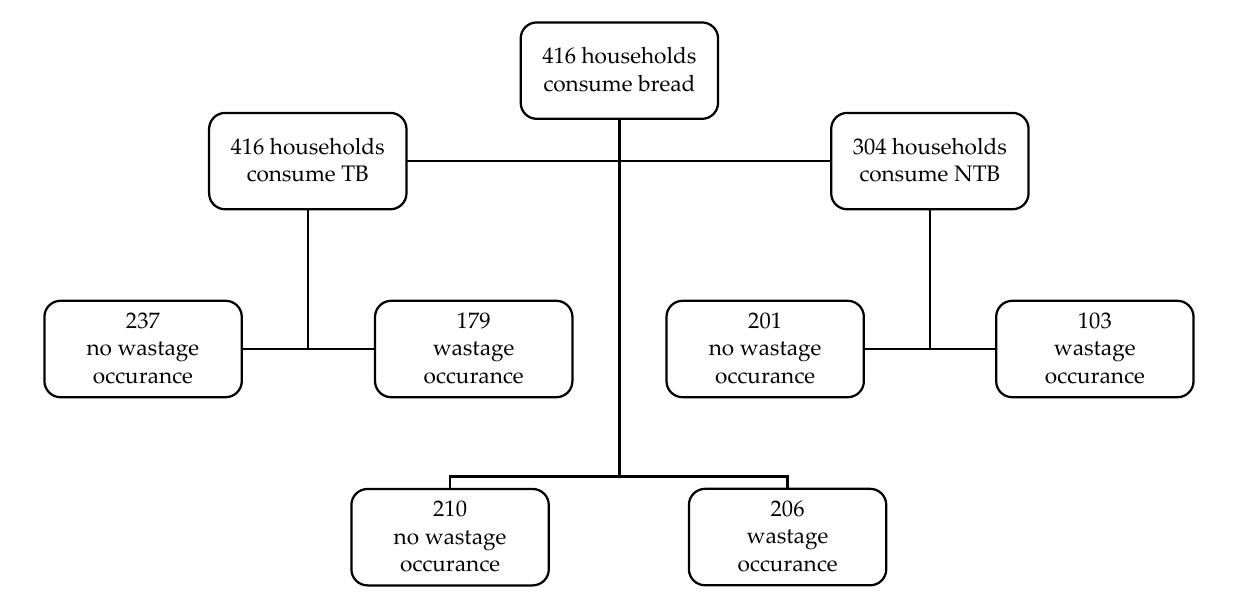
Figure 1. Schematic presentation of the number of households that consume bread and the number of households where bread wastage occurs, grouped based on bread categories; TB = traditional bread, NTB = non-traditional bread.